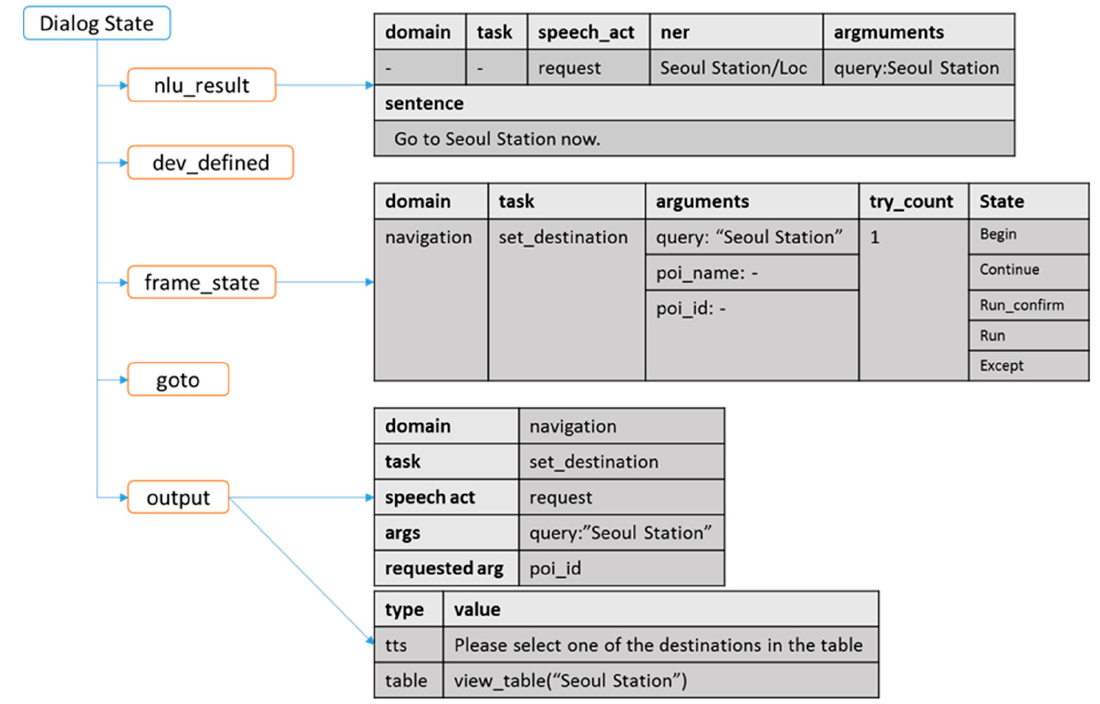
Figure 2. Dialog state properties.